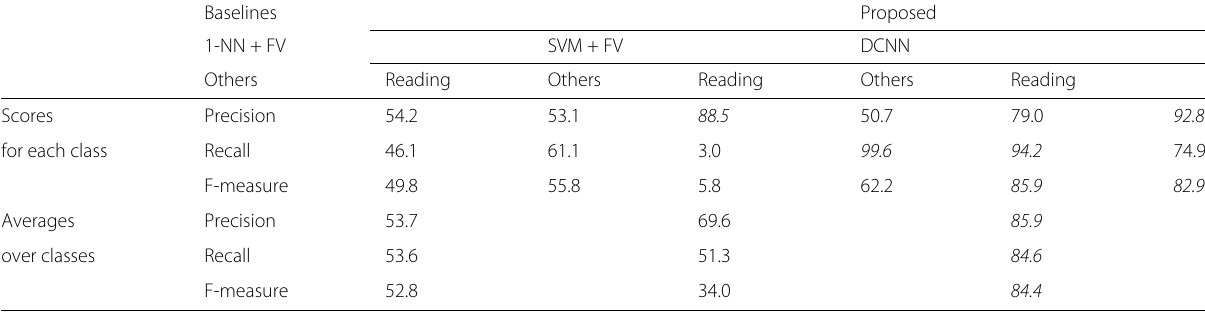
Table 6 Comparative result with the public dataset in Table 4